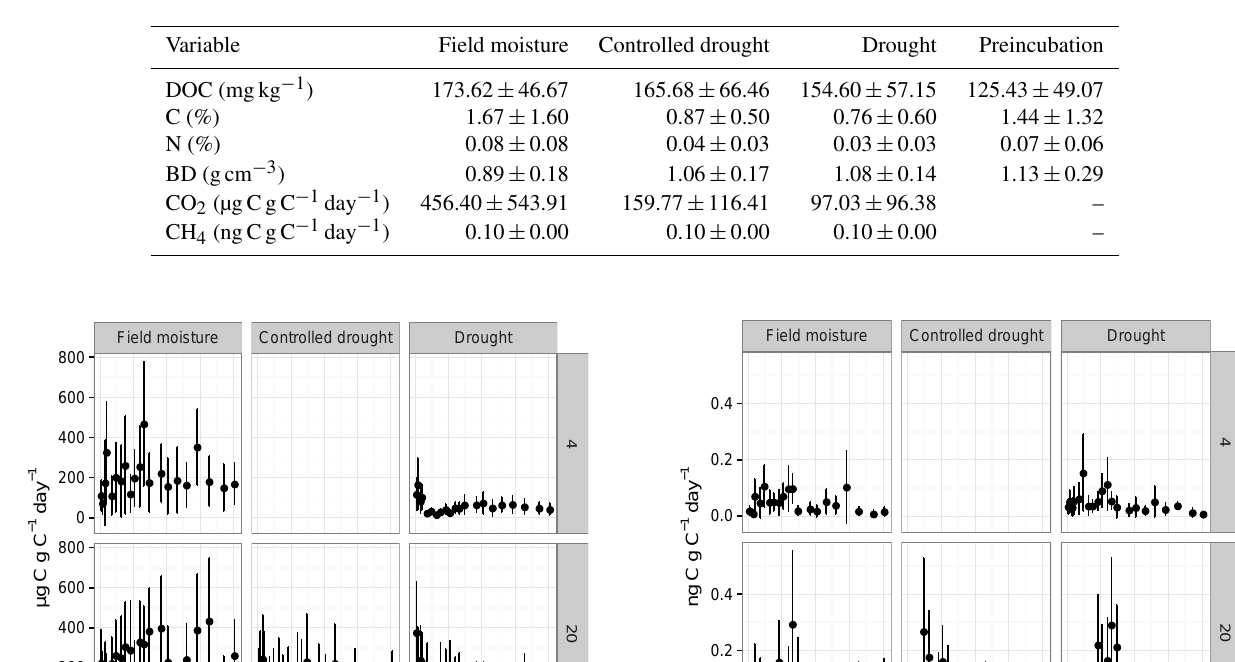
Table 1. Summary of dissolved organic carbon (DOC), percent C, percent N, bulk density (BD), and CO 2 and CH 4 fluxes by treatment. The field moisture and drought columns summarize (mean ± s.d.) 12 cores, combining two groups of N = 6 at each incubation temperature, while the controlled drought and pre-incubation columns are N = 6.